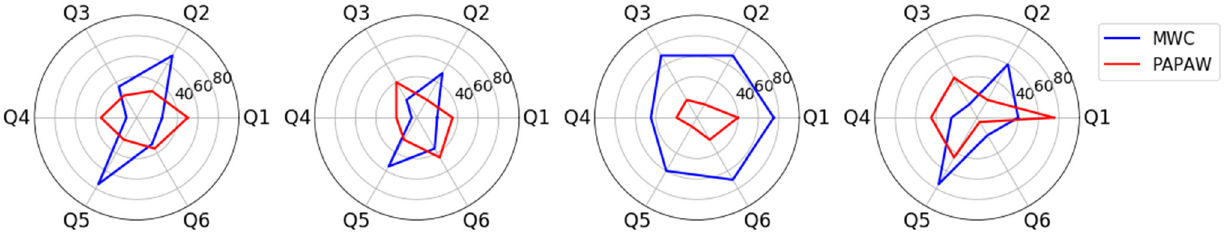
Figure 7. NASA-TLX scores for MWC and PAPAW tests. From left to right: Participants 1 to 4. Q1: Mental Demand’, Q2: ‘Physical Demand’, Q3: ‘Temporal Demand’, Q4: ‘Performance’, Q5: ‘Effort’, Q6: ‘Frustration’.